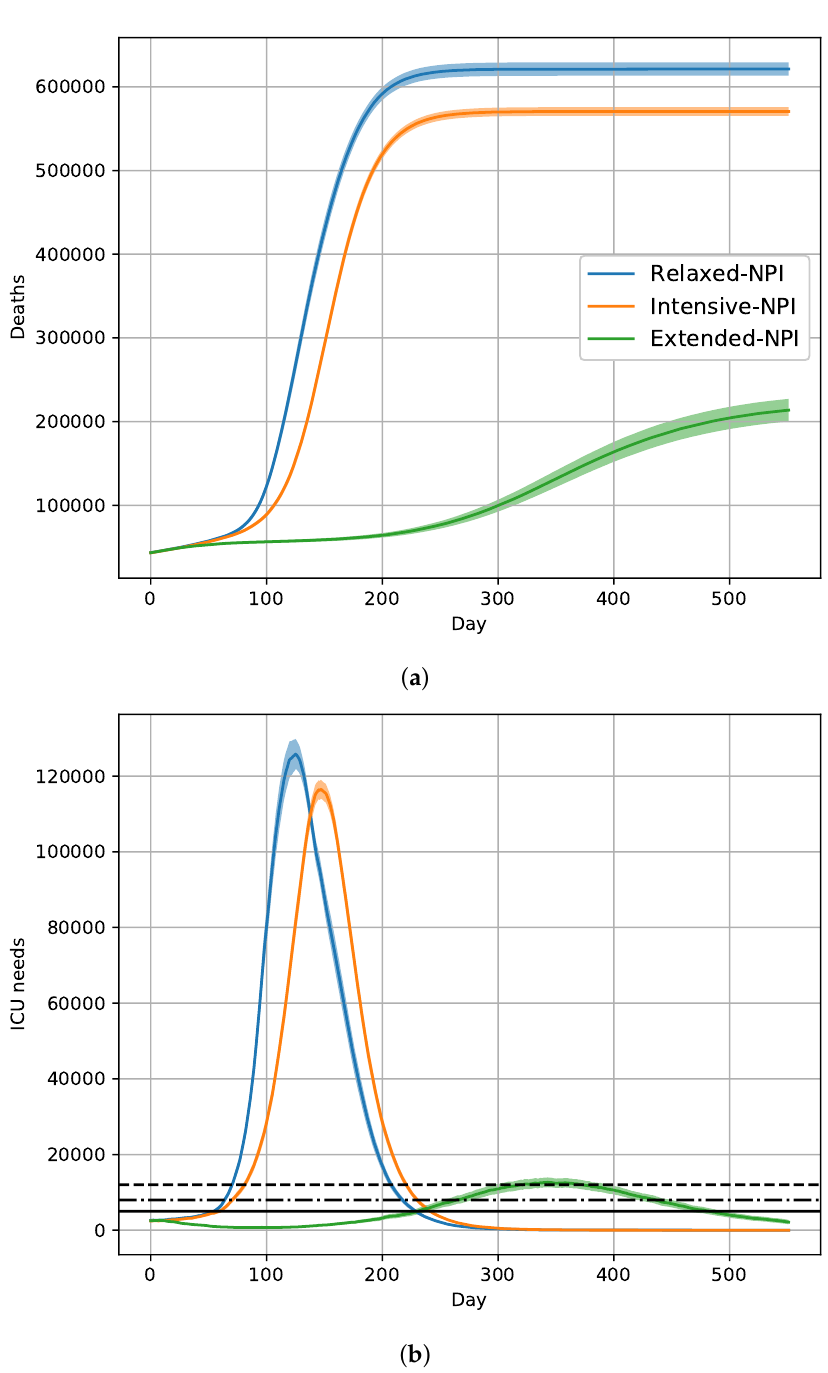
Figure 2. Expected evolution of the COVID-19 epidemic in France with the historical strain and Alpha variant, without vaccination, for extended-NPIs, intensive-NPIs, and relaxed-NPIs, as well as for 20% rate of asymptomatic subjects. Day 0 is 1 January 2021; ( a ) cumulative number of deaths. ( b ) Prevalence of COVID-19 patients needing Intense Care Units. The horizontal black lines represent an ICU capacity of 5000, 8000, and 12,000